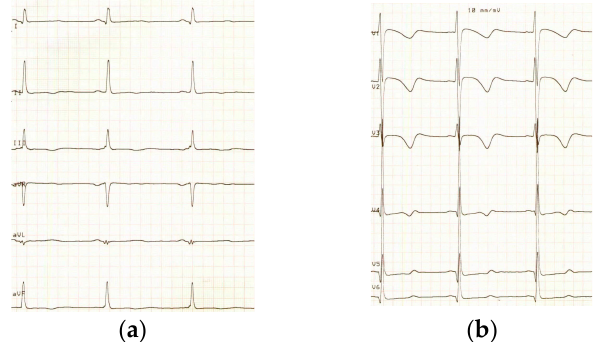
Figure 1. Twelve-lead electrocardiogram with limb leads ( a ) and chest leads ( b ). QT duration is 430 ms. The calculated duration of the QT interval corrected for heart rate by Bazzett’s formula is 470 ms. The recording speed is 50 mm/s and the amplitude is 10 mm/mV. Echocardiography demonstrated global left ventricular hypertrophy with a dilated aortic root (Z-score calculated according to [7]: 2.5) and grade I aortic insufficiency (Figure